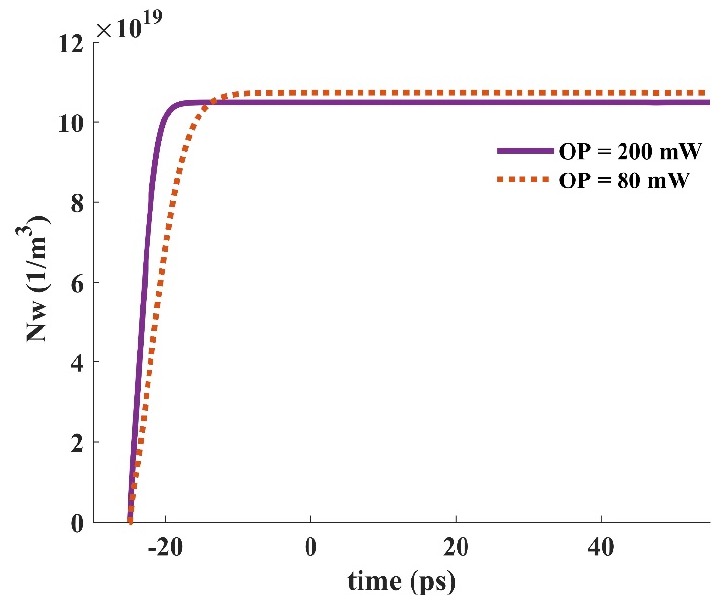
Figure 17. The electron concentration in the wetting layer for distinct optical pump power (input signal power = 1 μ W).